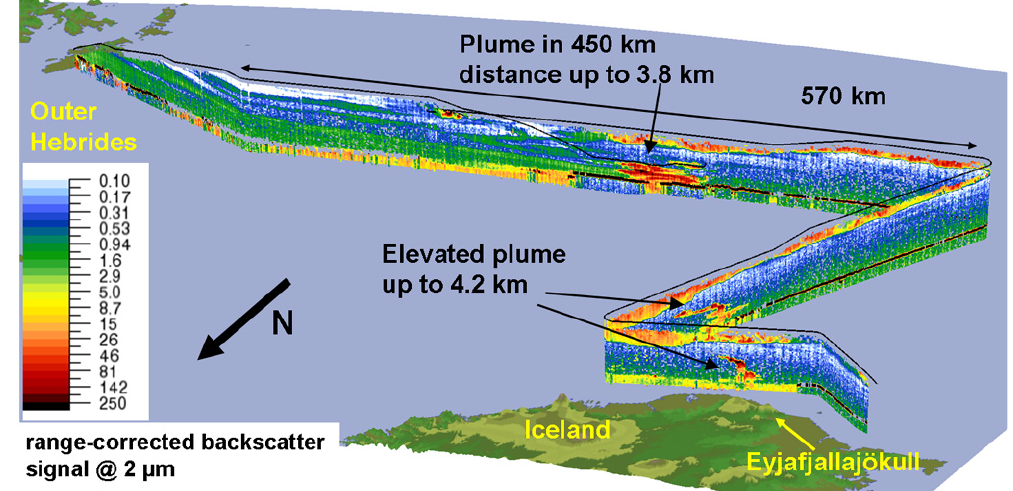
Fig. 12. Lidar cross-section showing the range corrected backscatter signal along the flight path from Iceland to Scotland on 2 May 2010. The flight altitude above the Eyjafjallaj¨okull was